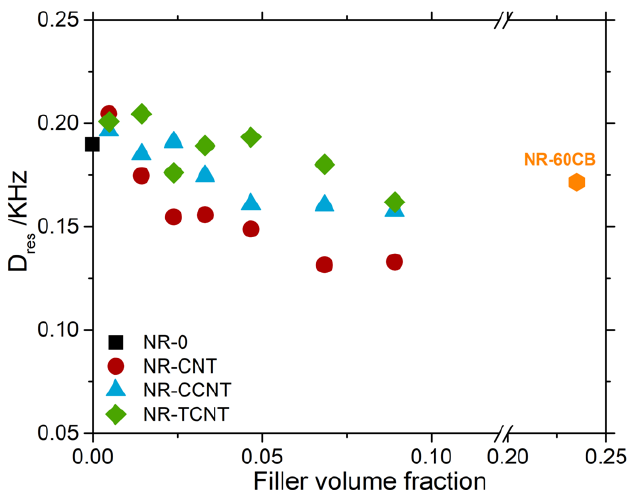
Figure 19. Evolution of residual dipolar coupling value of the distribution maximum as a function of the filler volume fraction of the NR compounds filled with pristine and functionalized CNTs.